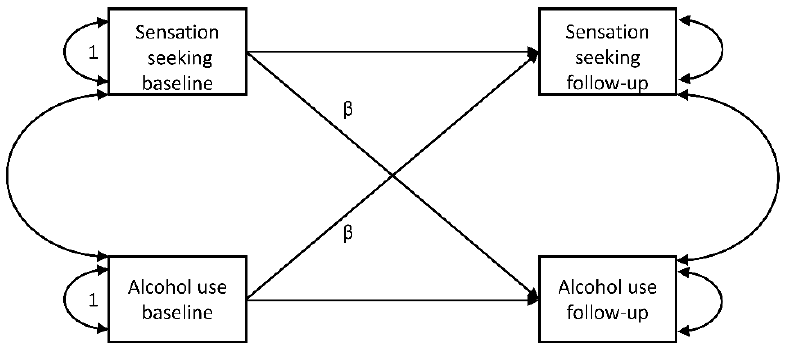
Figure 2. Theoretical Cross-lagged Model for Observed Variables of Alcohol Use and Sensation- Seeking Traits. Note . β s are the cross-lagged paths. 1s are unstandardized fixed variances. Models were calculated for two alcohol variables (binge and volume) and sensation seeking as total scale and for the four